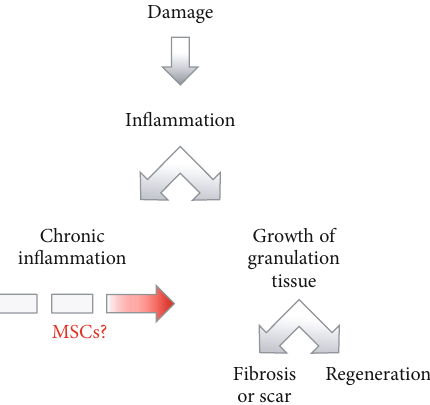
Figure 1: Pathophysiological variants of case scenario in tissue repair after injury. The best case scenario for wound healing is tissue regeneration — the complete repair of structure and function. Adults usually experience wound healing with various degrees of scar formation. Tissue repair does not occur if chronic in fl ammation develops. The strategy to control the in fl ammatory response is a shift in the balance from chronic in fl ammation toward tissue